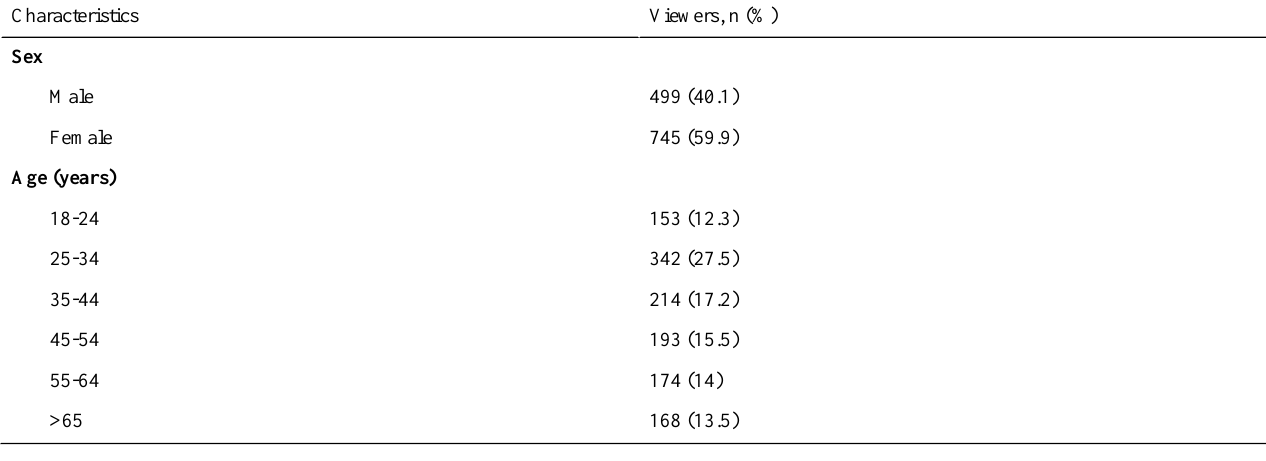
Table 1. Demographic data